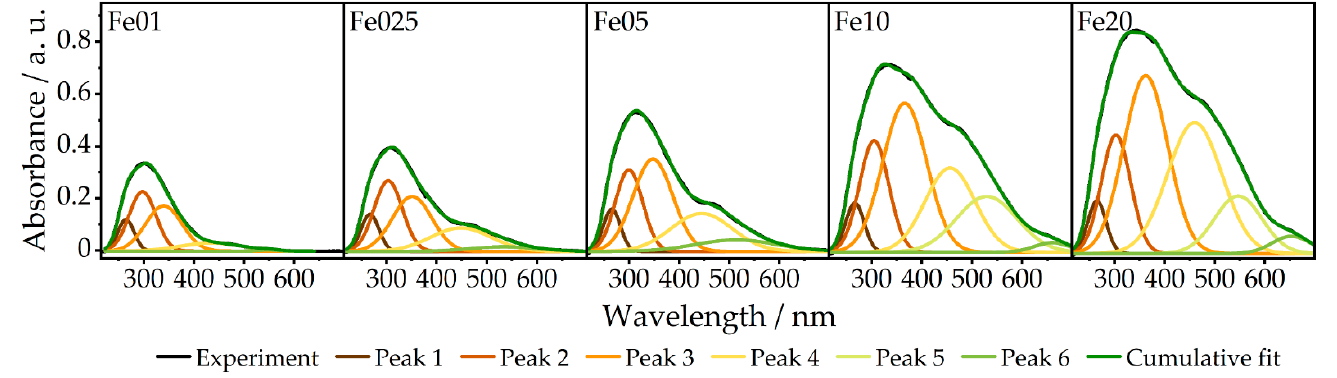
Figure 7. Experimental DRUV spectra of Fe01 to Fe20 and the corresponding peak deconvolution with cumulative peak fit.